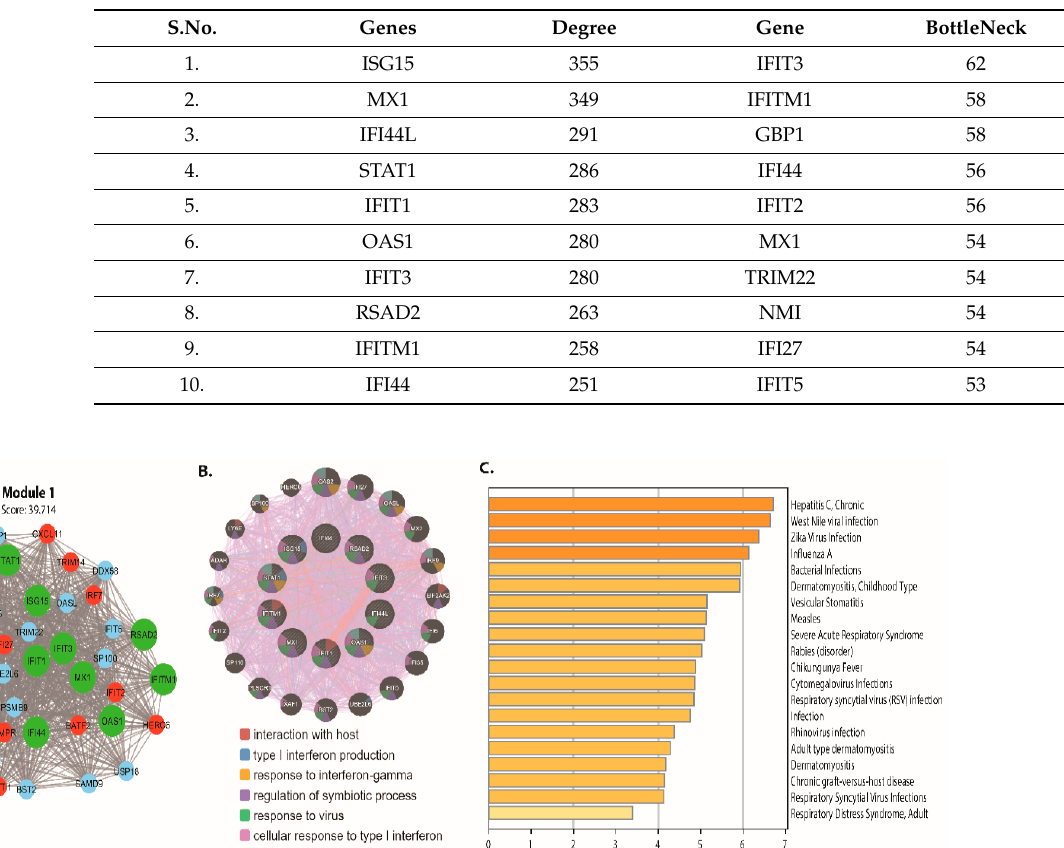
Figure 5. PPI network construction of differential expressed genes in C. parvum infected patient’s intestinal epithelial tissue ( A ) PPI network of CPI DEGs red circles represents upregulated DEGs, cyan circle represents downregulated DEGs, and the green circle represents hub genes. ( B ) p -values are used to colour a bar graph of enriched terms across all total ex- pressed genes. ( C ) The most significant module was obtained from PPI network. Table 1. Top 10 hub genes expressed in intestinal epithelial tissue of C. parvum infected patient and its topological properties.